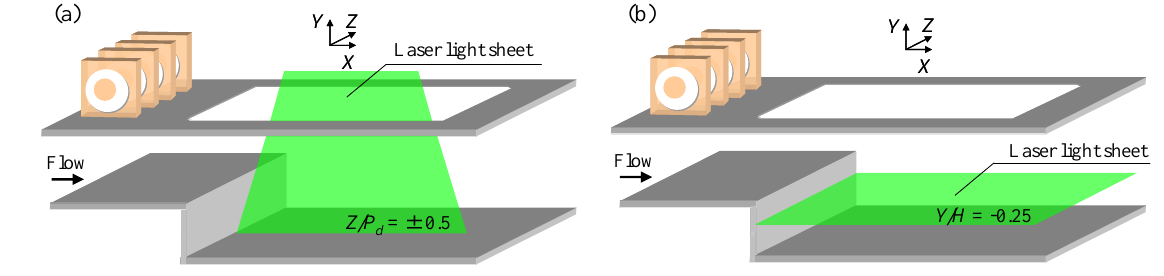
Fig. 3 Flow visualization in (a) X-Y and (b) X-Z